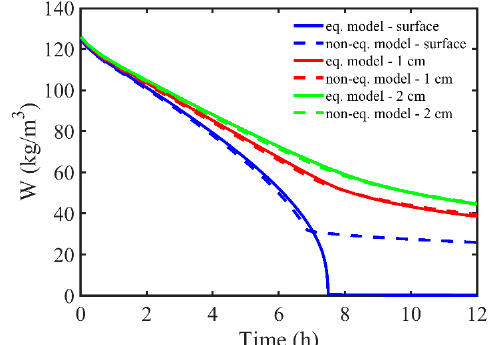
Figure 5. Comparison of temporal variations of the volumetric moisture content predicted with non-equilibrium and equilibrium models, at the surface and inside the dried brick, at a distance of 1 and 2 cm from the surface.